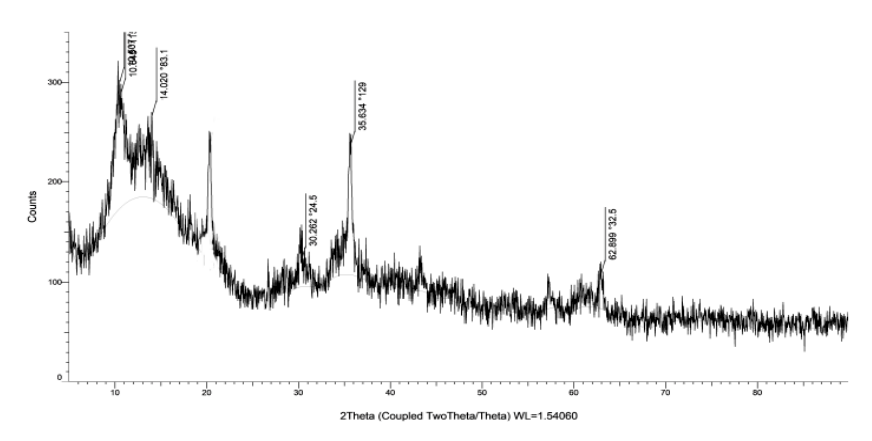
Figure 1. The XRD pattern of Fe@Co-Al layered double hydroxide (LDH).